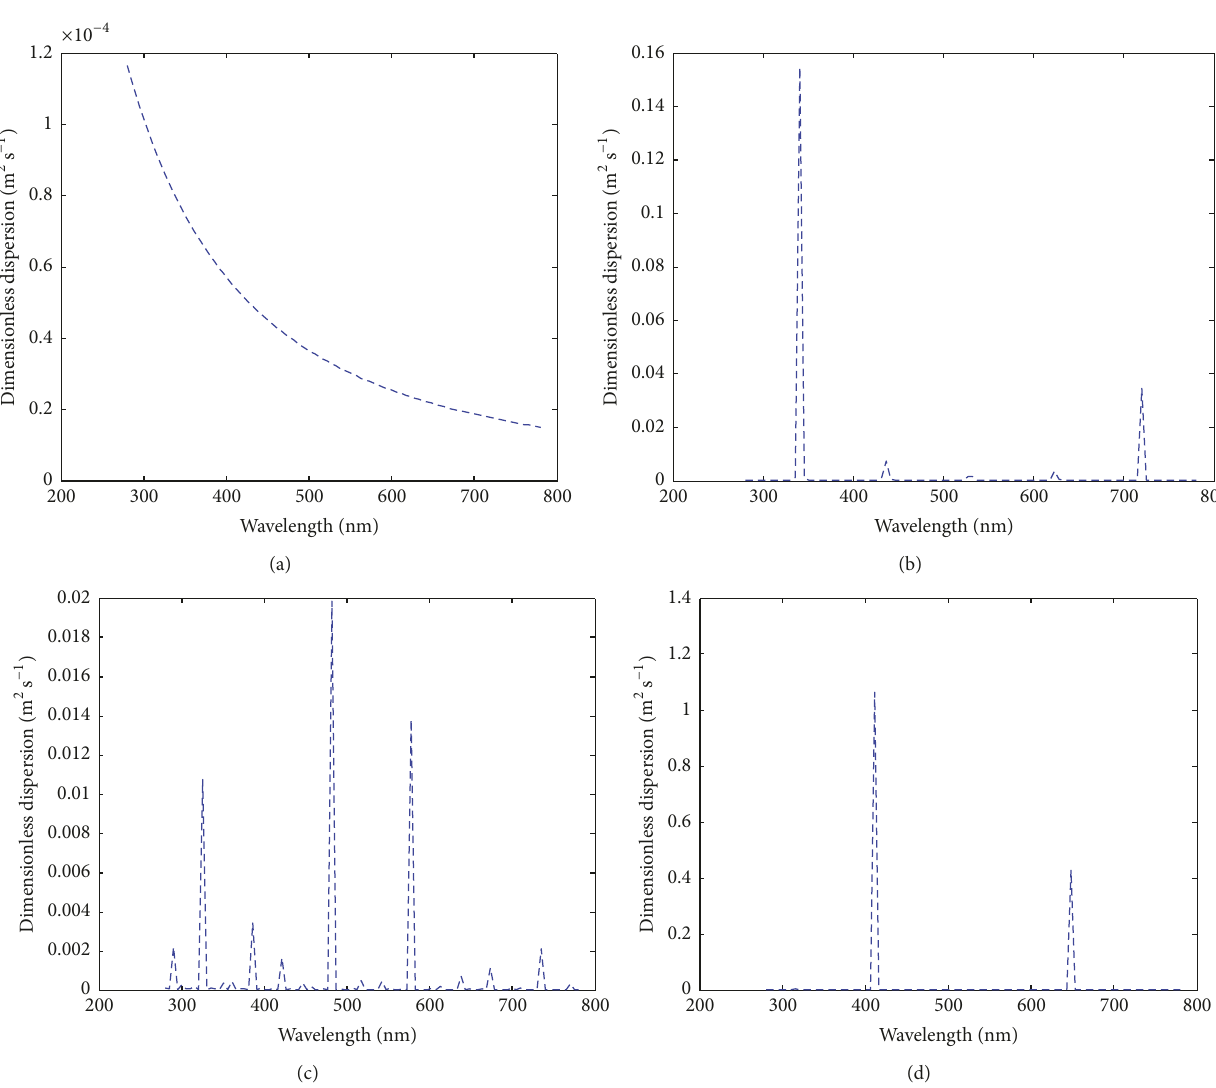
shapes: cube with truncated/irregular edges plausibly due to the effect of Ostwald ripening and multiply twinned hybrid after 30 minutes of the reaction with a mean particle size of 9.86 ± 2.37 nm. Structural elucidation from the TEM image also revealed formation of core-shell Ag/Ni